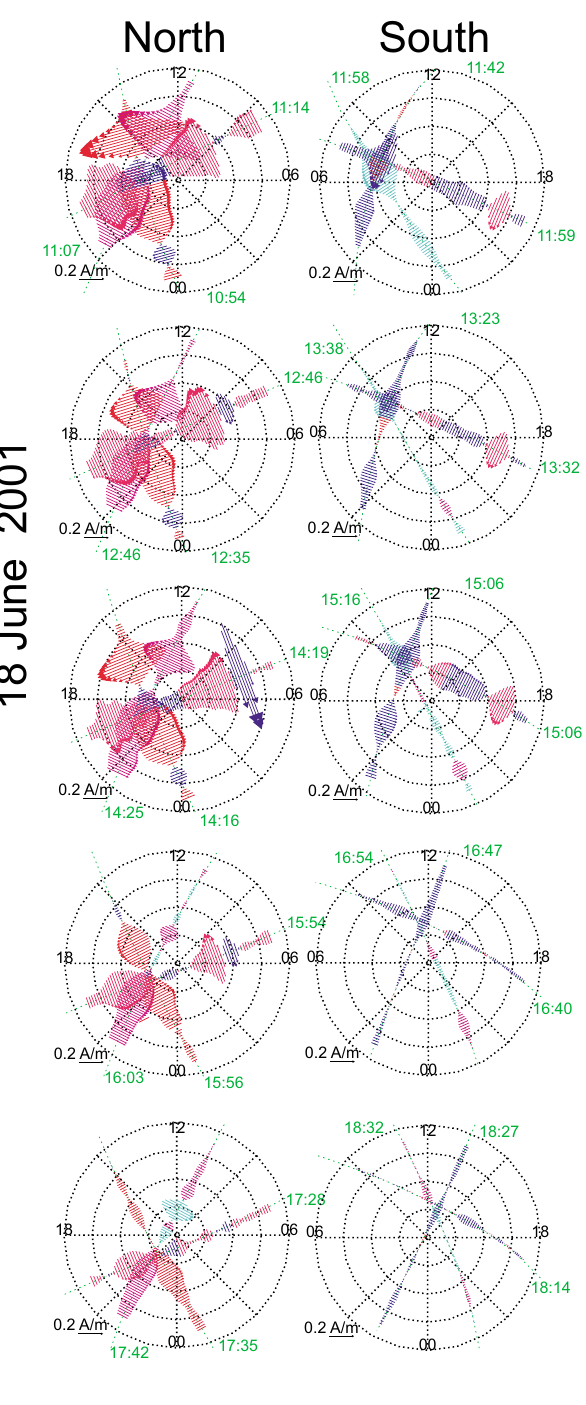
Fig. 8. Displayed here are the combined ionospheric current maps for 5 consecutive orbits on 18 June 2001. The format of the po- lar maps is like the one in Fig. 1. Model currents from all three satellites, Ørsted, CHAMP and SAC-C are overlaid in the plots. Ørsted currents are plotted in blue and red (same as previous fig- ures), CHAMP currents in purple and crimson, and SACC currents in light blue and magenta. Start times for the passes are marked in green. The Northern Hemisphere crossings are to the left and the Southern Hemisphere crossings to the right, as marked at the